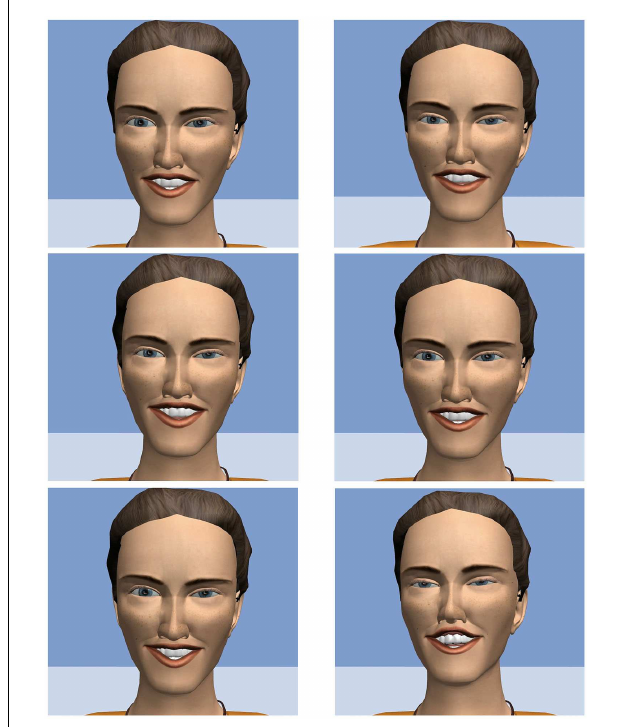
FIGURE 1 |Apex of the laughter events of the six stimuli .Top row: two low-intensity laughs (left side: AU6B, AU12B, and AU25C; right side: AU6B, AU12B, and AU25B). Mid row: two medium intensity laughs (left side: AU6C, AU12C, and AU25C; right side: AU6C, AU12C, and AU25C). Bottom row: two high-intensity laughs (left side: AU4C, AU6D, AU12D, AU25D; AU6E, AU12E, and